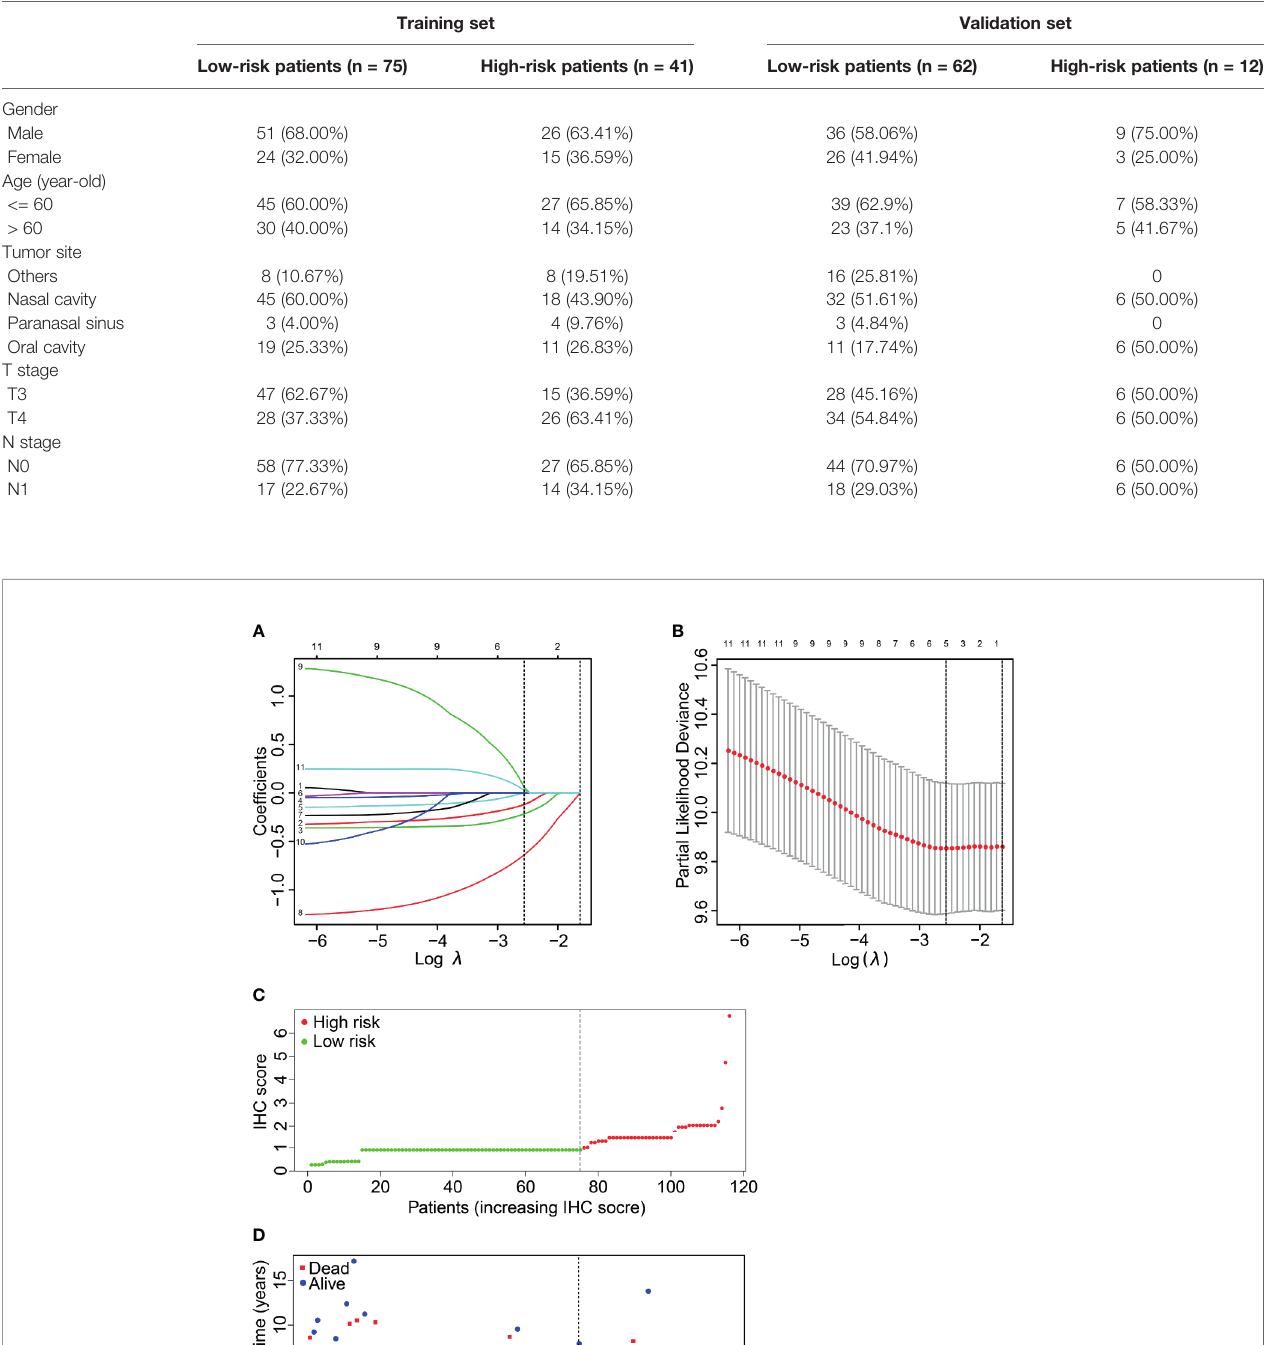
TABLE 1 | Baseline characteristics between the primary cohort and validation cohort.